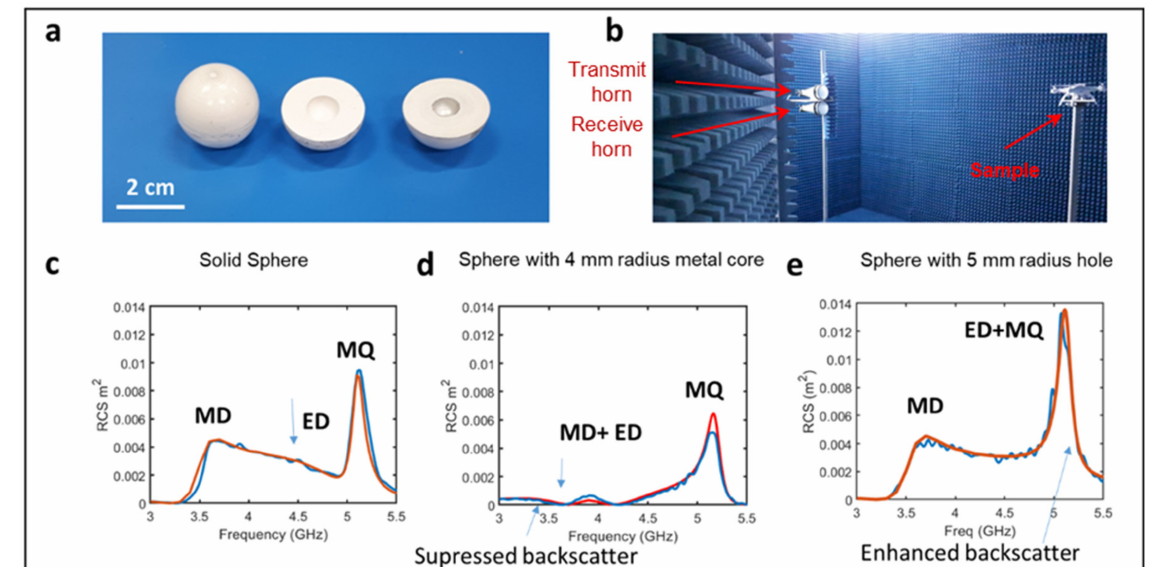
Figure 1. Experimental demonstration of suppression and enhancement of backscatter through mode stacking. ( a ) Spherical samples milled as two hemispheres from premix 1050. From left to right—solid, 5 mm radius hole and 4 mm radius metallic core. ( b ) The anechoic chamber used to take experimental data set up for quasi-monostatic RCS measurements. Experimental (blue) and simulated (red) RCS of ( c ) a solid sphere, ( d ) a sphere with a 4 mm metal core and ( e ) a sphere with a 5 mm radius